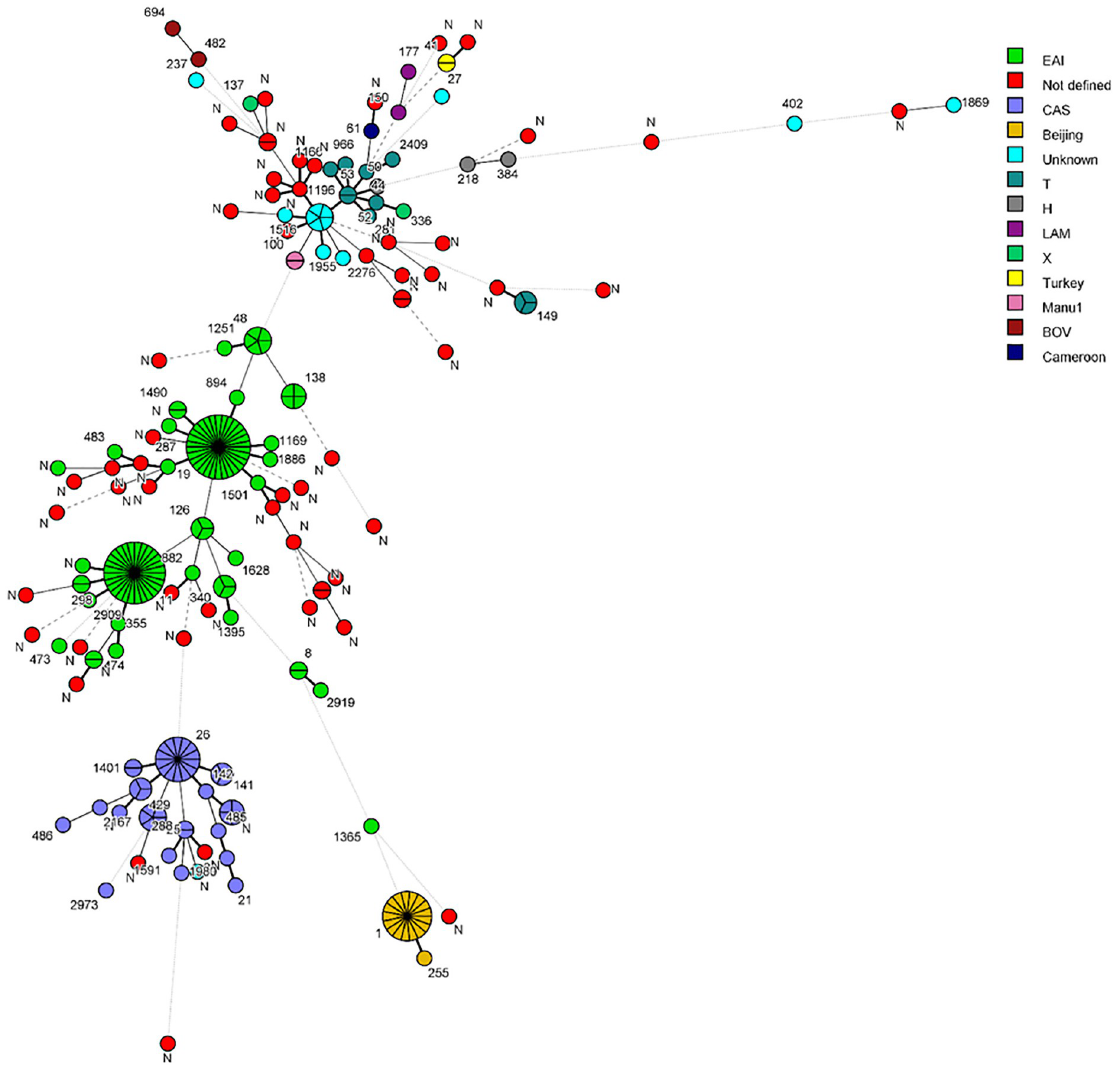
Fig 3. A minimum spanning tree (MST) showing evolutionary relationships based on spoligotypes in M . tuberculosis population (n = 256 isolates). The phylogenetic tree connects each genotype based on degree of changes required to go from one allele to another. The structure of the tree is represented by branches (continuous vs. dashed and dotted lines) and circles representing each individual pattern. The length of the branches represents the distance between patterns while the complexity of the lines (continuous, gray dashed and gray dotted) denotes the number of allele/spacer changes between two patterns: solid lines, 1 or 2 or 3 changes (thicker ones indicate a single change, while the thinner ones indicate 2 or 3 changes); gray dashed lines represent 4 changes; and gray dotted lines represent 5 or more changes. The size of the circle is proportional to the total number of isolates in the study, presenting unique isolates (smaller nodes) versus clustered isolates (bigger nodes). The color of the circles indicates the phylogenetic lineage to which the specific pattern belongs. The labels of nodes indicate SITs in the study. (N indicates orphan or new spoligotype